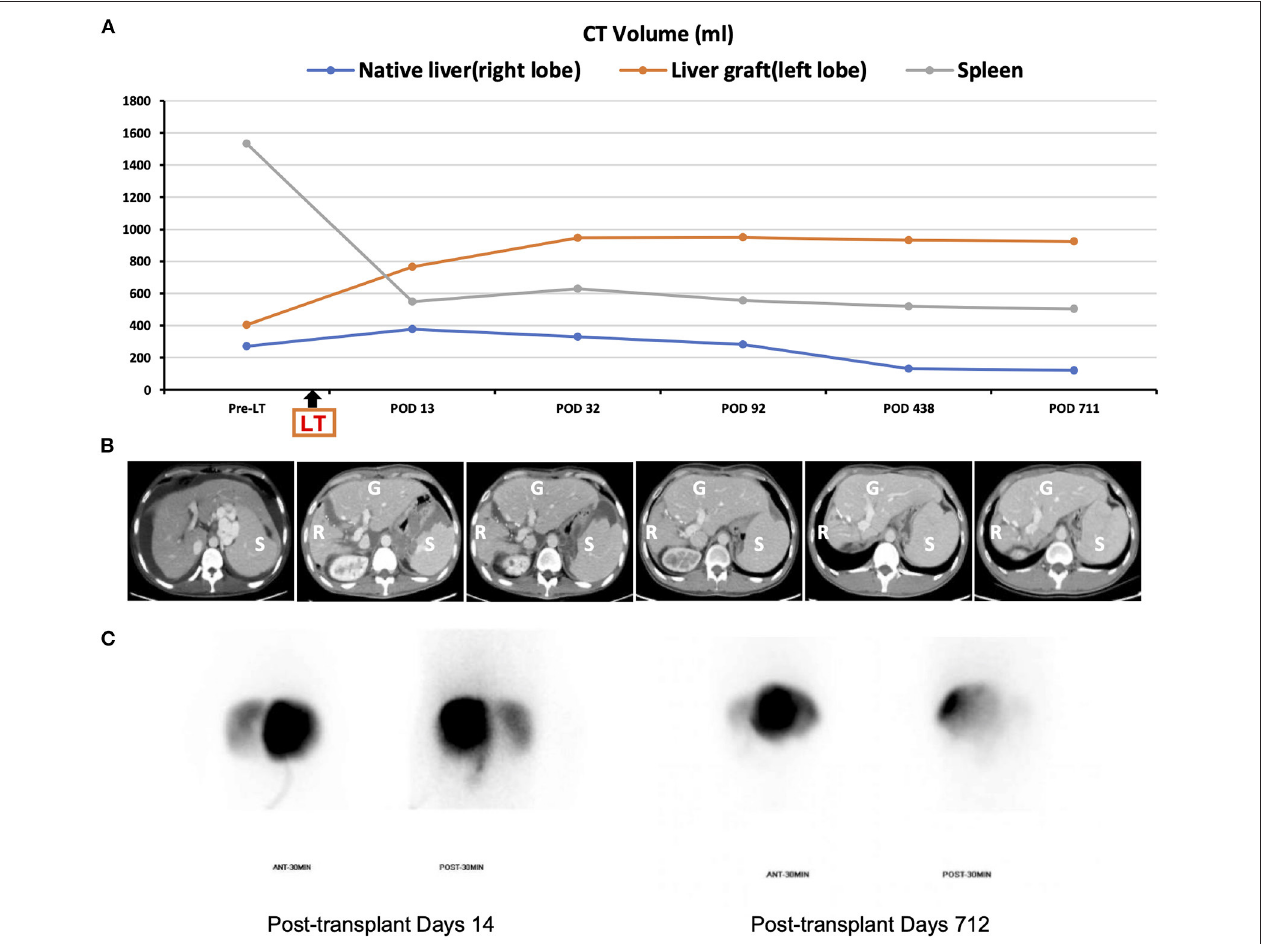
FIGURE 3 | Pre- and postoperative imaging. (A) Changes in CT-simulated volume of the native residual liver, graft, and spleen throughout follow-up; (B) representative abdominal CT images (R, liver remnant; G, graft; S, spleen); (C) Tc-99m hepatobiliary scintigraphy on post-transplant day 14 and 712 (left liver graft: right native liver = 88%: 12 and 97.9%: 2.1%,